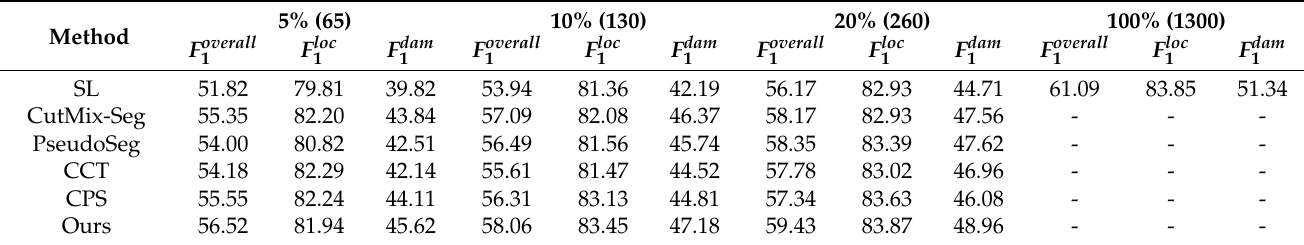
Table 5. Quantitative comparison of different SSL methods on the Michael dataset